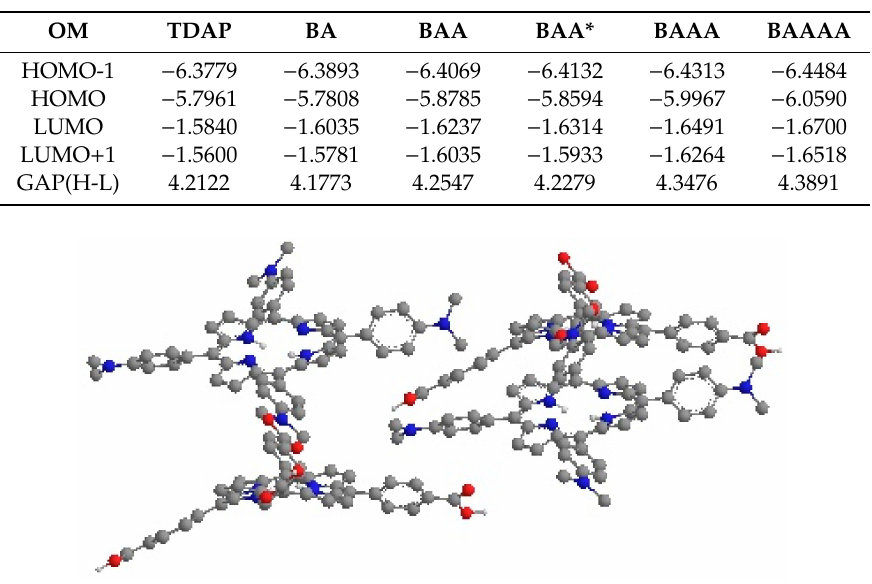
Table A1. Frontier Molecular Orbitals, values of the energy in eV and GAP (HOMO-LUMO).